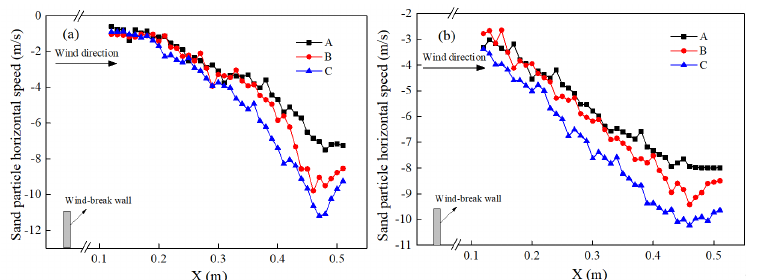
Figure 9. Sand particle’s horizontal speed along the leeward side ( u ∗ = 0.9701 m/s). ( a ) H = 0.05 m (above the track). ( b ) H = 0.10 m (above the track).